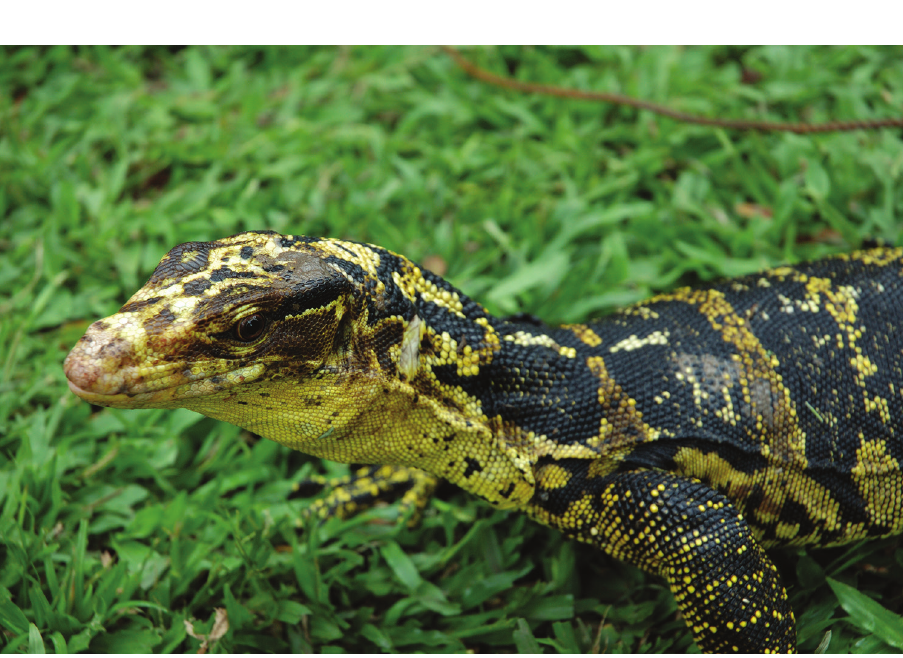
Figure 63. Varanus cumingi photographed at the Municipality of Mambajao, Camiguin Sur Island. Photo: CDS (specimen not